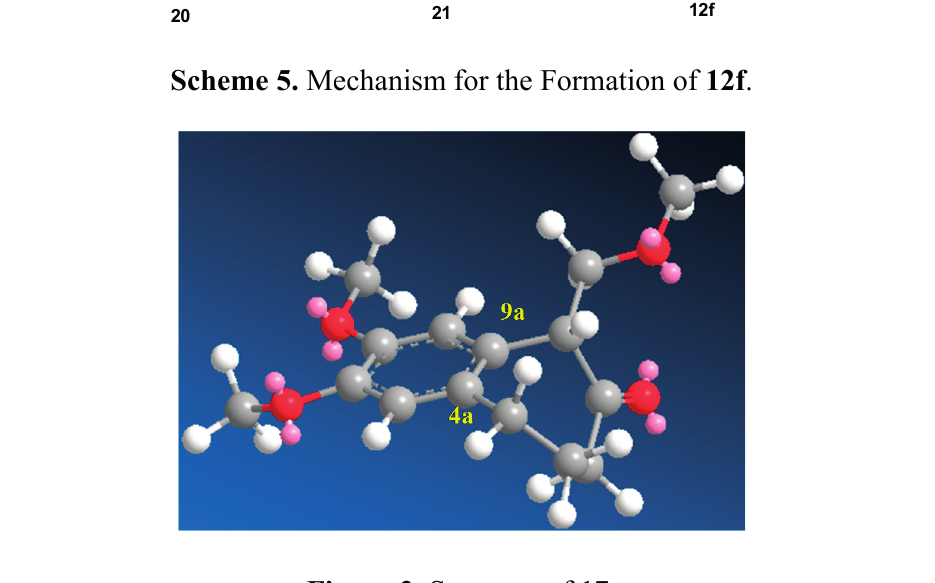
Figure 3. Structure of 17